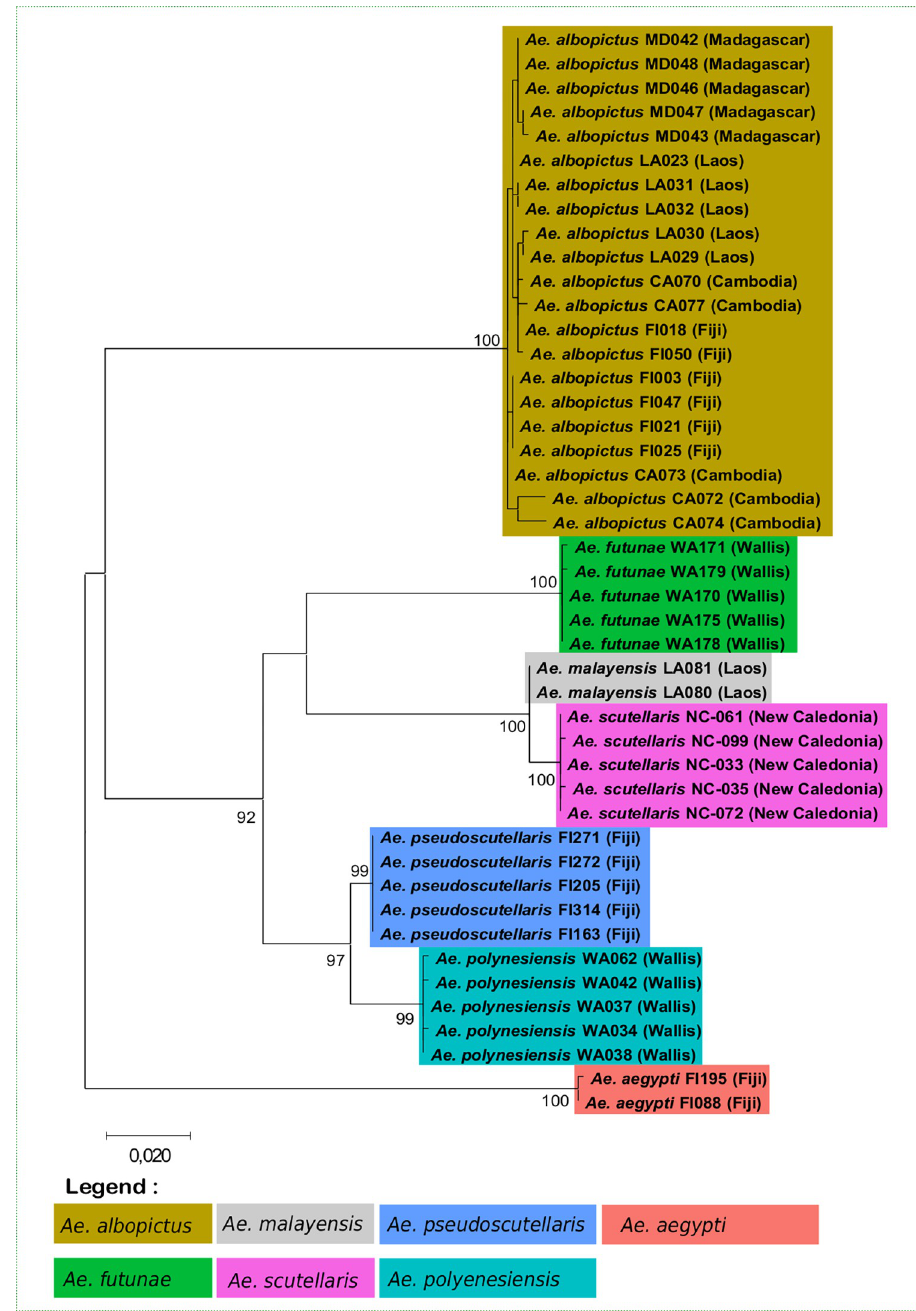
Fig 3. Maximum likelihood evolutionary (MLE) relationships of mosquito species of the Scutellaris Group. Tree derived from 45 concatenated sequences. For analysis, the percentage of replicate trees in which the associated taxa clustered together in the bootstrap test (1000 replicates) is shown for values over 80. The country of collection is indicated along with the specimen number. Colors indicate mosquito